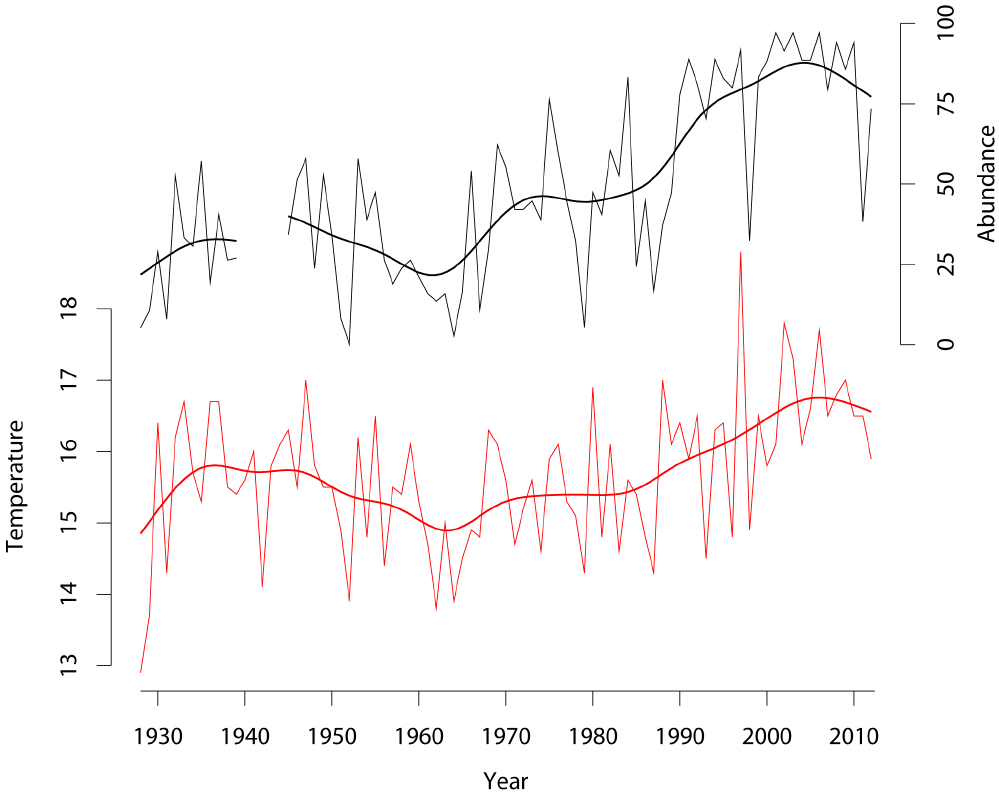
Figure 1. Average water temperature during summer (red) and percentage occurrence of corkwing wrasse (black) in beach seine hauls in Skagerrak from 1928 to 2012, based on annual measurements by the Institute of Marine Research [ 61 ] . Solid lines represent kernel smoothed averages (using function ksmooth of the R statistical package [62]).